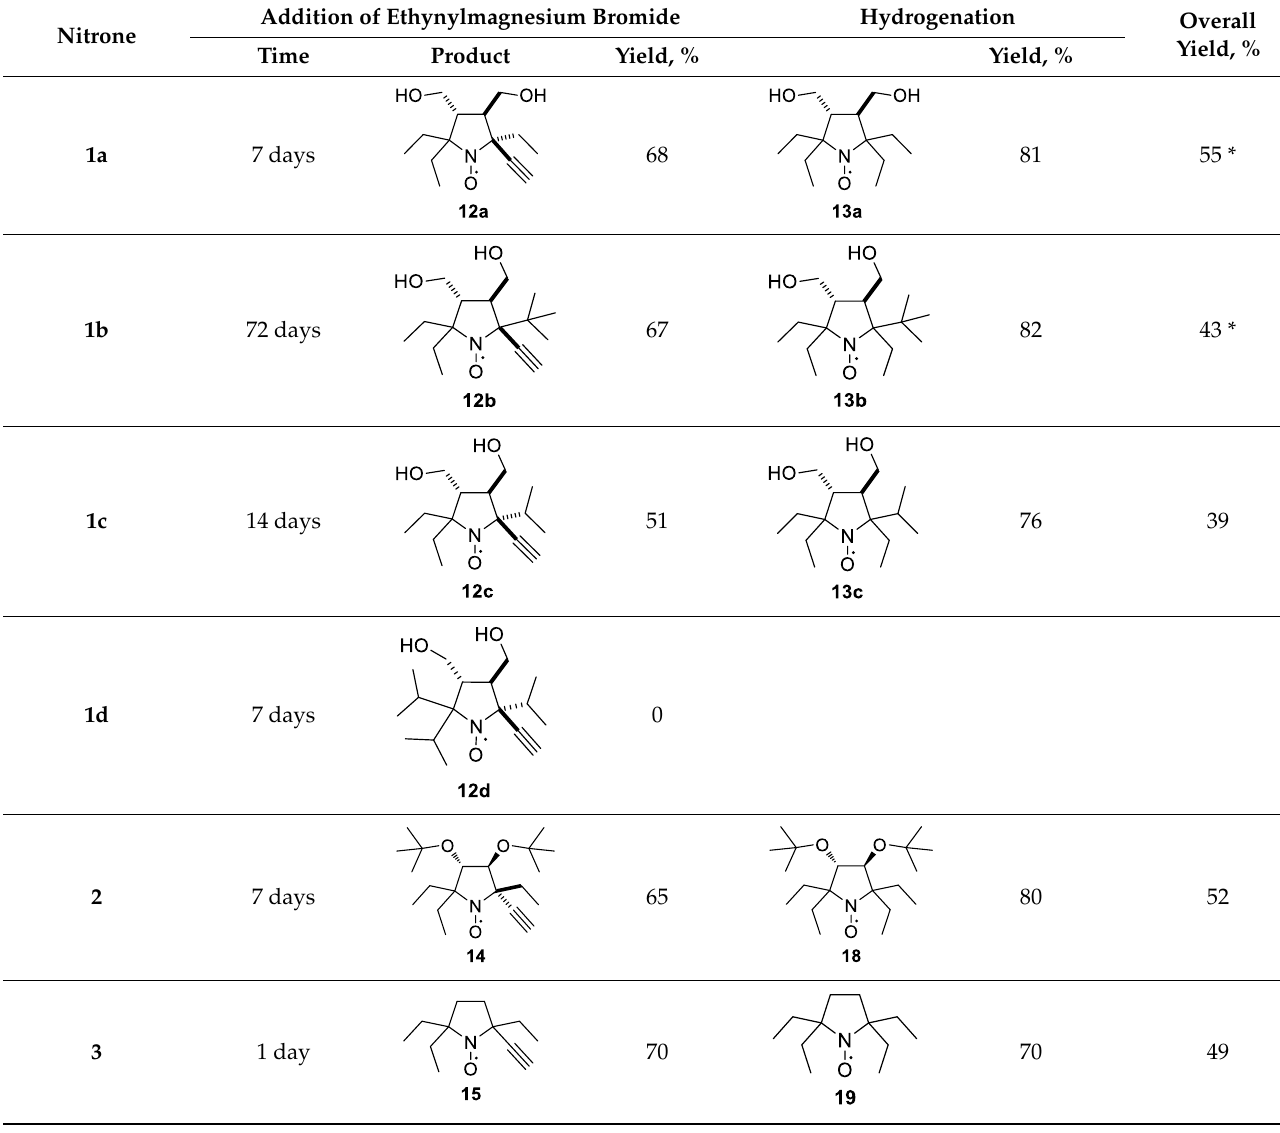
Table 1. Synthesis of nitroxides from nitrones: reaction times and yields (for conditions, see the Section 3).